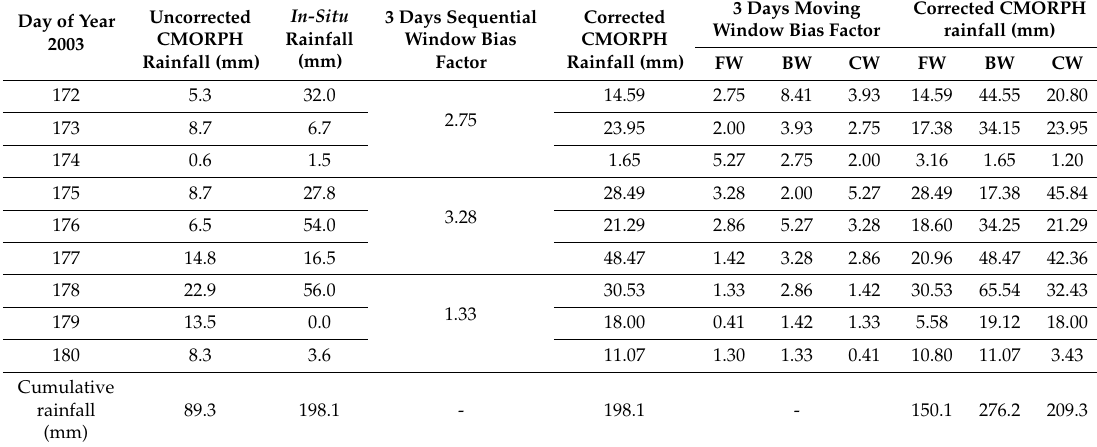
Table 1. BF calculation using MW and SW (FW, BW and CW schemes)